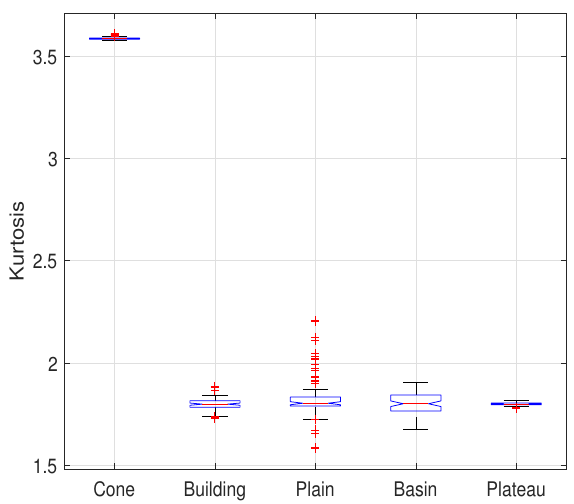
Figure 5. Boxplot of kurtosis corresponding to various